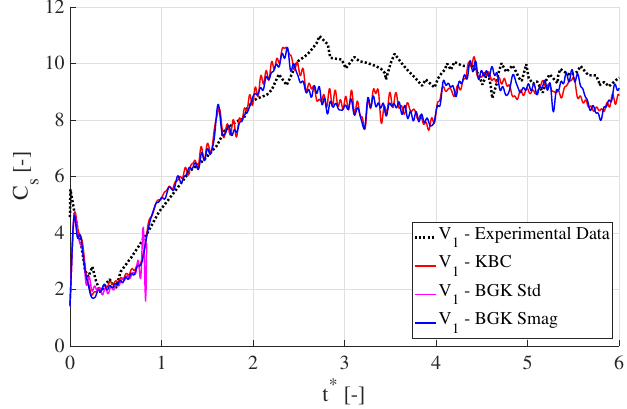
Figure 9. Comparison between experimental results presented by [32] and numerical model at Fr = 0.4628. Black dotted line represents experimental findings, solid red line the KBC results, magenta line the BGK without turbulence model, and the blue curve represents the BGK with Smagorinsky sub-grid model.